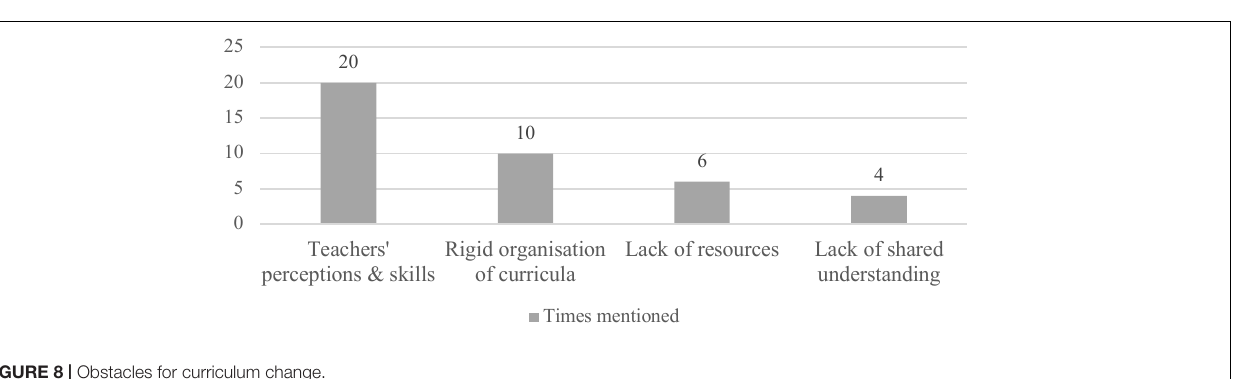
FIGURE 8 | Obstacles for curriculum